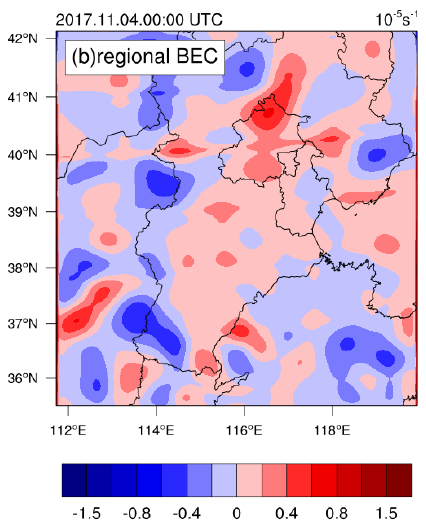
Fig.6. Same as Fig.5, but for surface temperature( o